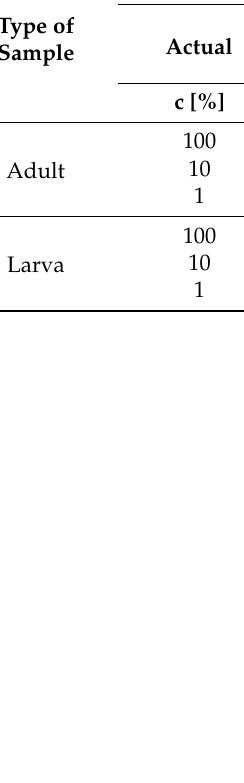
Table 9. Results of determination of yellow mealworm in commercial food